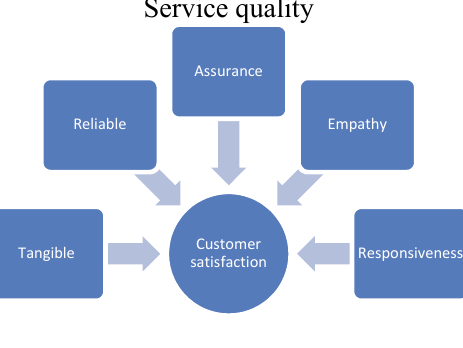
Fig. 1. Theoretical Framework